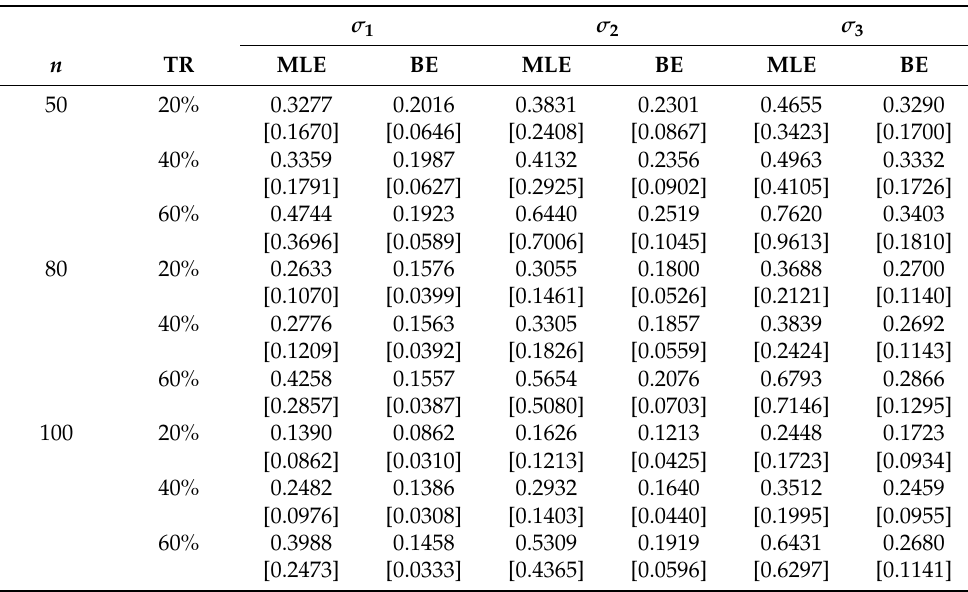
Table 3. ABs and MSEs (within bracket) for parameters with order restriction when ( σ 1 , σ 2 , σ 3 ) =